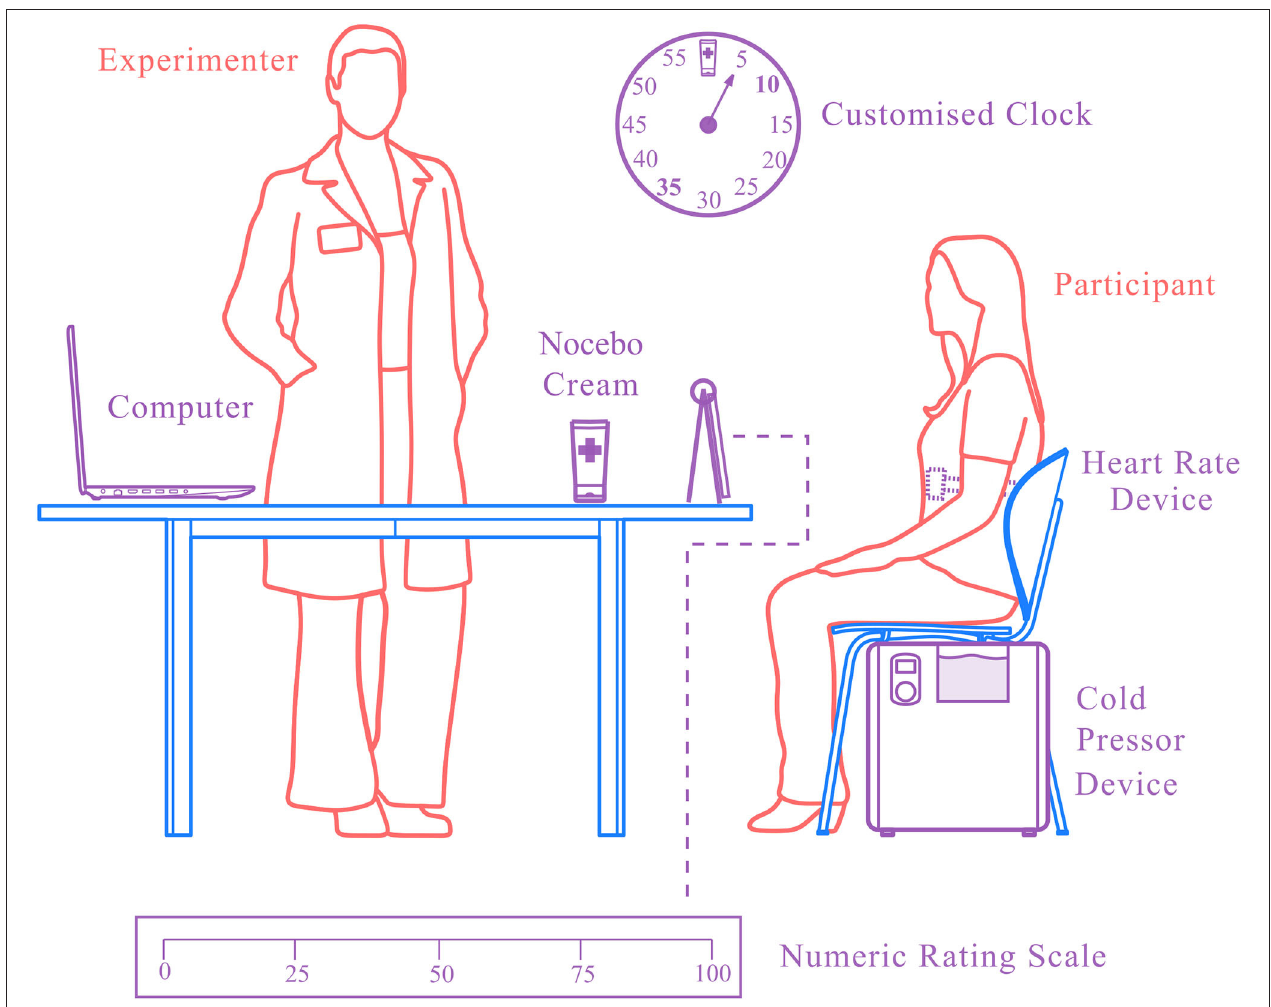
FIGURE 1 | Experimental